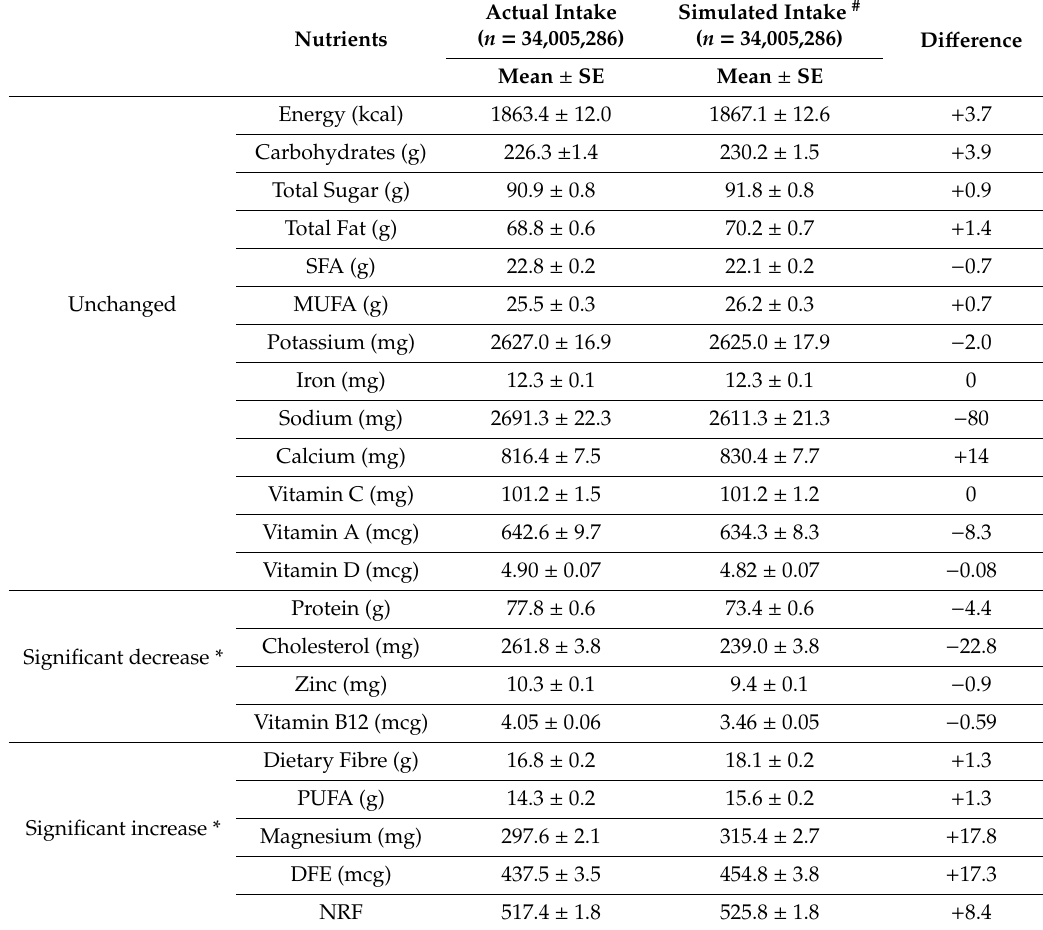
Table 4. Comparison of daily energy and nutrient intakes between the Canadian Community Health Survey (CCHS) 2015 and the simulated results among Canadians aged 1 year and older. Actual Nutrients